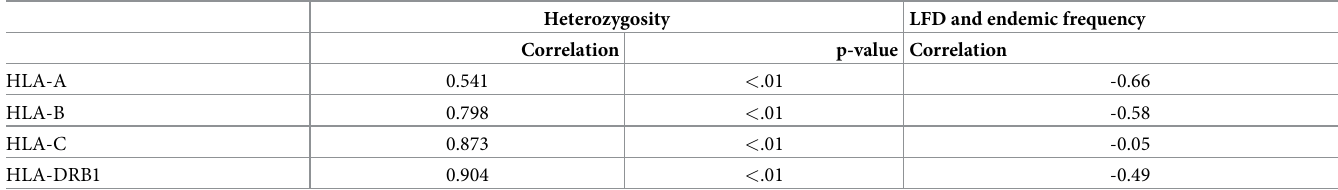
Table 2. Correlation between mean microsatellite heterozygosity and HLA diversity (heterozygosity and abundance of endemic alleles).